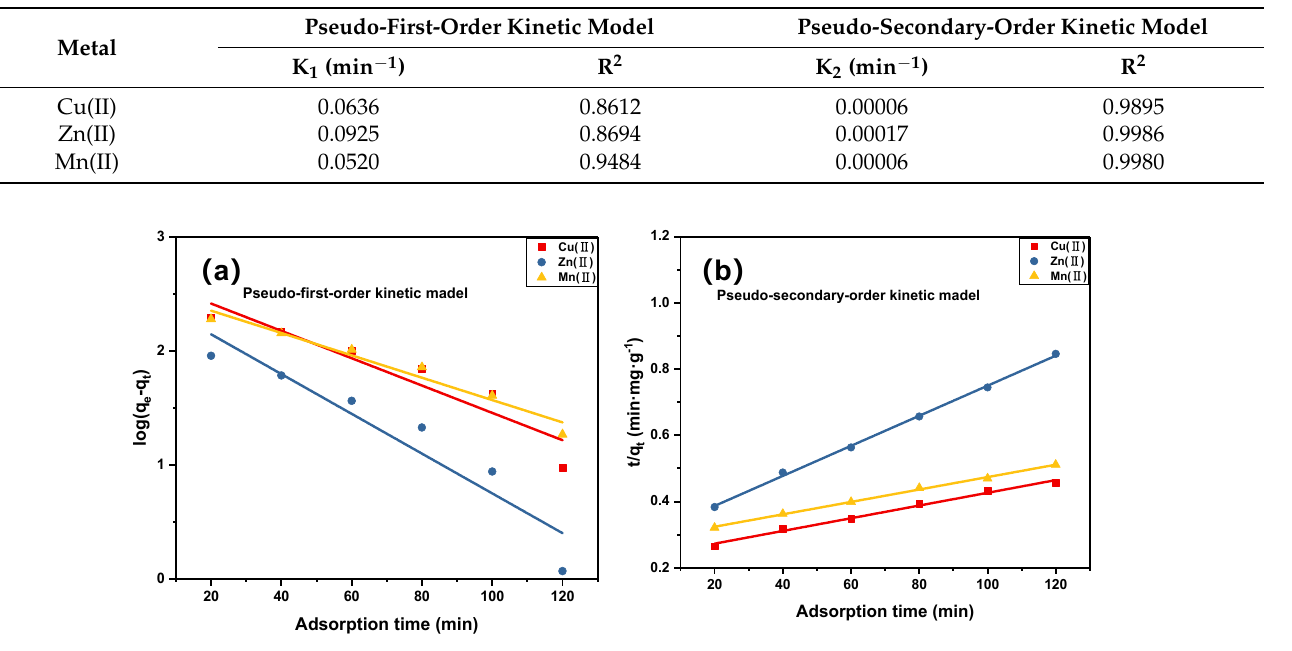
Figure 6. ( a ) Pseudo-first-order kinetic model and ( b ) pseudo-secondary-order kinetic model fitting curves of the experimental data at optimum reaction conditions. Table 2. Kinetic parameters for Cu(II), Mn(II), and Zn(II) ion adsorption onto aerogel spheres.